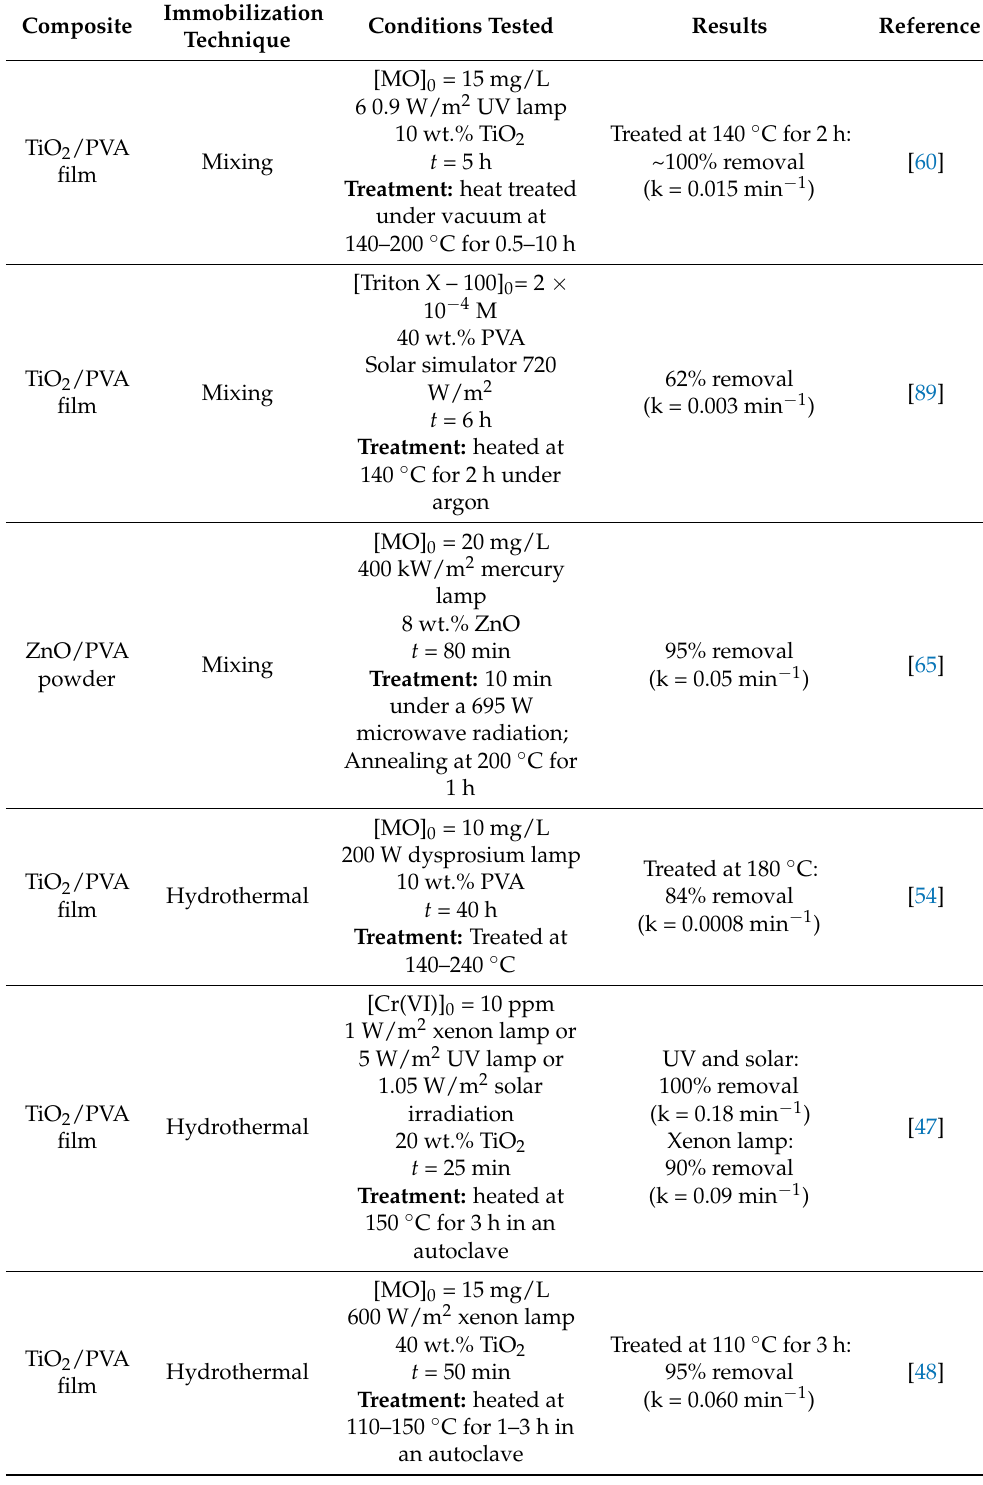
Table 11. Summary of studies that have analyzed the effect of the heat treatment on the PVA- supported photocatalysis